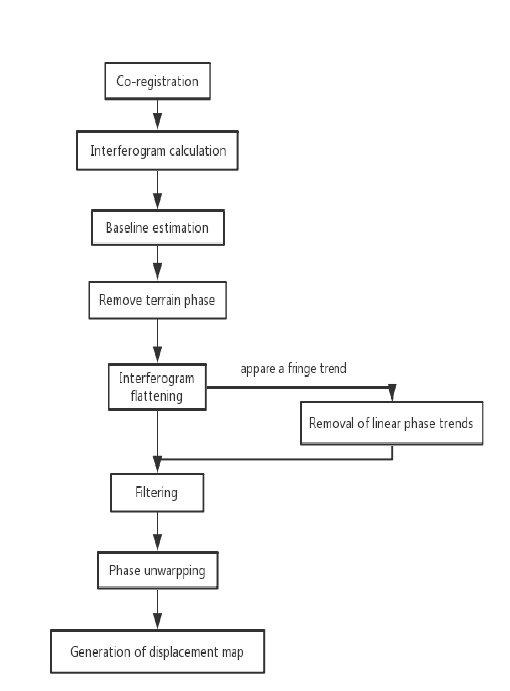
Figure 3. Two-pass method DInSAR processing flow chart